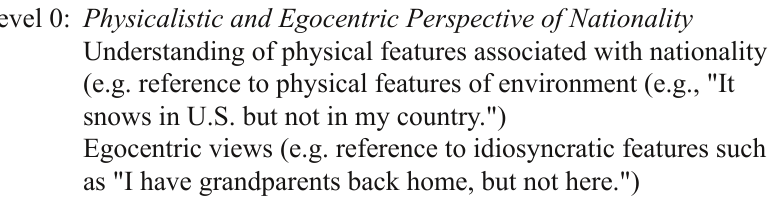
Summary Description of Children’s Answers of Perspective­Taking Ability for Nationality Level 0: Physicalistic and Egocentric Perspective of Nationality Understanding of physical features associated with nationality (e.g. reference to physical features of environment (e.g., "It snows in U.S. but not in my country.") Egocentric views (e.g. reference to idiosyncratic features such as "I have grandparents back home, but not